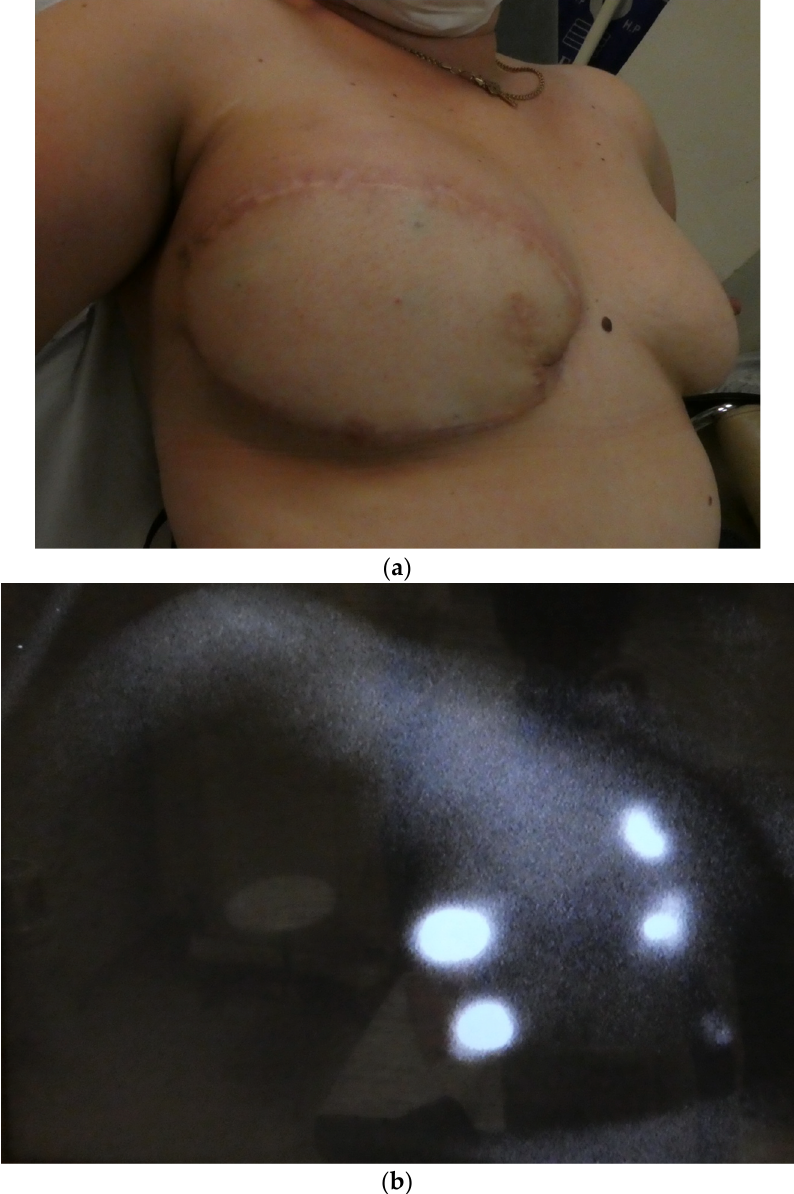
Figure 5. ( a ) DIEP flap breast reconstruction with classical design. ( b ) Breast reconstruction with classical design. No lymphatic flow restoration was observed at one year post-operatively.